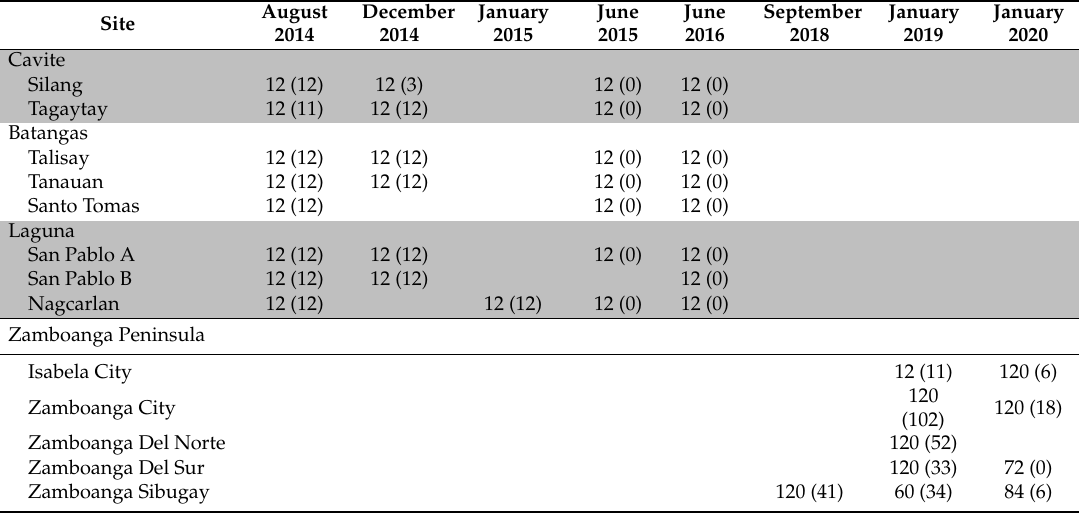
Table 1. Distribution of leaflet segment samples collected in study sites with confirmed Aspidiotus rigidus infestations. Numbers in parentheses indicate the number of segments with A. rigidus